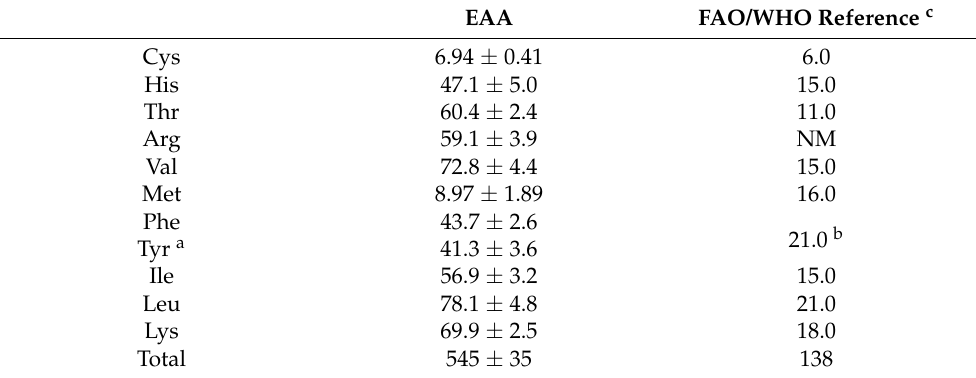
Table 4. Essential amino acids content (EAA) (mg/g protein) of peptide-rich extract obtained from autolysis of ESY1.